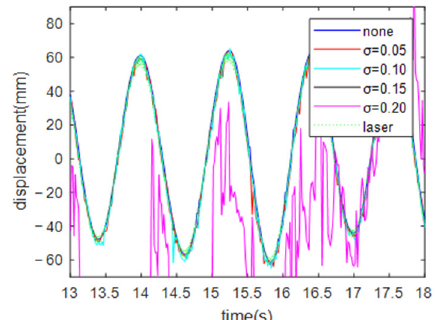
Figure 12. Comparison of displacement identification results under different white noise.